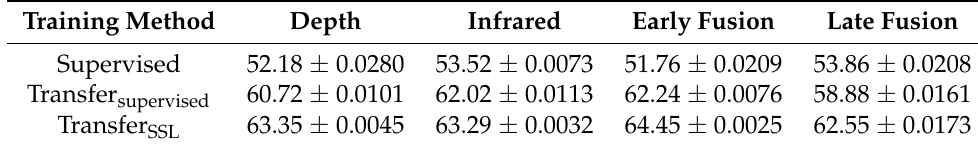
Table 3. Validation accuracy on 10% of training data (unit: